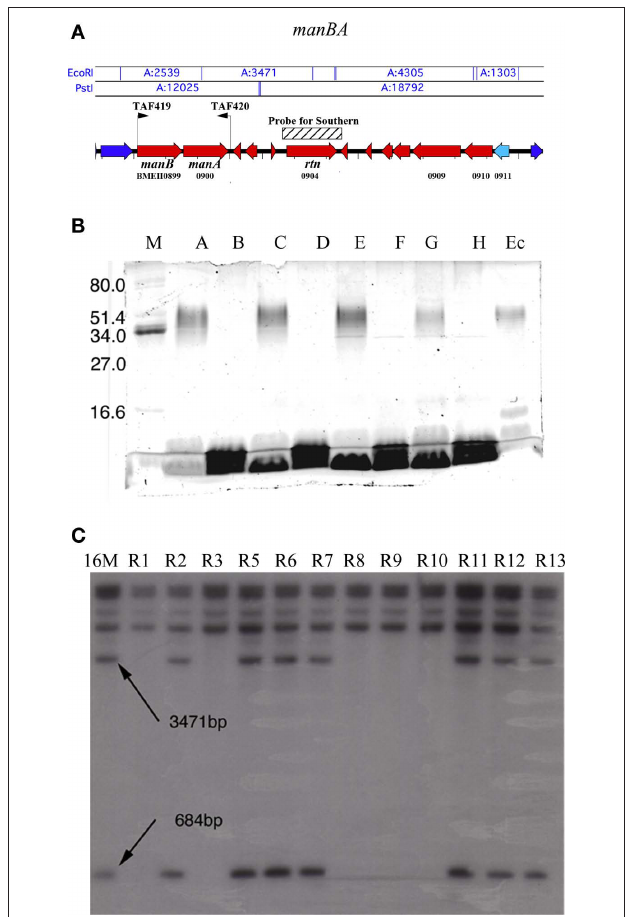
FiguRE 1 | genomic variation among isolates of B. melitensis 16M in stock culture originally obtained from aTCC. A preliminary genetic screen of Brucella rough variants revealed large genomic rearrangement. (a) Schematic of the manBA locus, showing the full extent of the deletion as characterized by primer walking. Primers for amplification of manBA (TAF419 and TAF420) are indicated. Unaffected genes (dark blue), truncated genes (light blue) and completely deleted genes (red). (B) Representative figure demonstrating Pro-Q Emerald 300 glycoprotein staining of Brucella LPS separated on SDS-PAGE using manBA knockout strains developed for this work and the ability to complement the deletion with the pJET1445 expression construct (C) ; marker (lane M), B. melitensis 16M (lane A), B. melitensis ∆ manBA (lane B), B. melitensis 16M ∆ manBA/pJET1445 (lane C), B. melitensis 16M ∆ manBA/pBBR1MCS6-y (lane D), B. abortus S2308 (lane E), B. abortus ∆ manBA (lane F), B. abortus 16M ∆ manBA/pJET1445 (lane G), B. abortus 16M ∆ manBA/pBBR1MCS6-y (lane H), E. coli O55:B5 expressing smooth LPS (lane Ec), (rtn, BMEII0904), demonstrating naturally occurring deletion of manBA. The arrows indicate two digested fragments of the rtn locus (3471 and 684 bp, respectively) that are lost with the deletion of manBA. R1–R13 are different spontaneous rough isolates, representing two broad classes of mutants. (C) Southern blot of PstI/EcoRI-digested genomic DNA isolated from B. melitensis rough isolates probed with a randomly 32 P-labeled probe